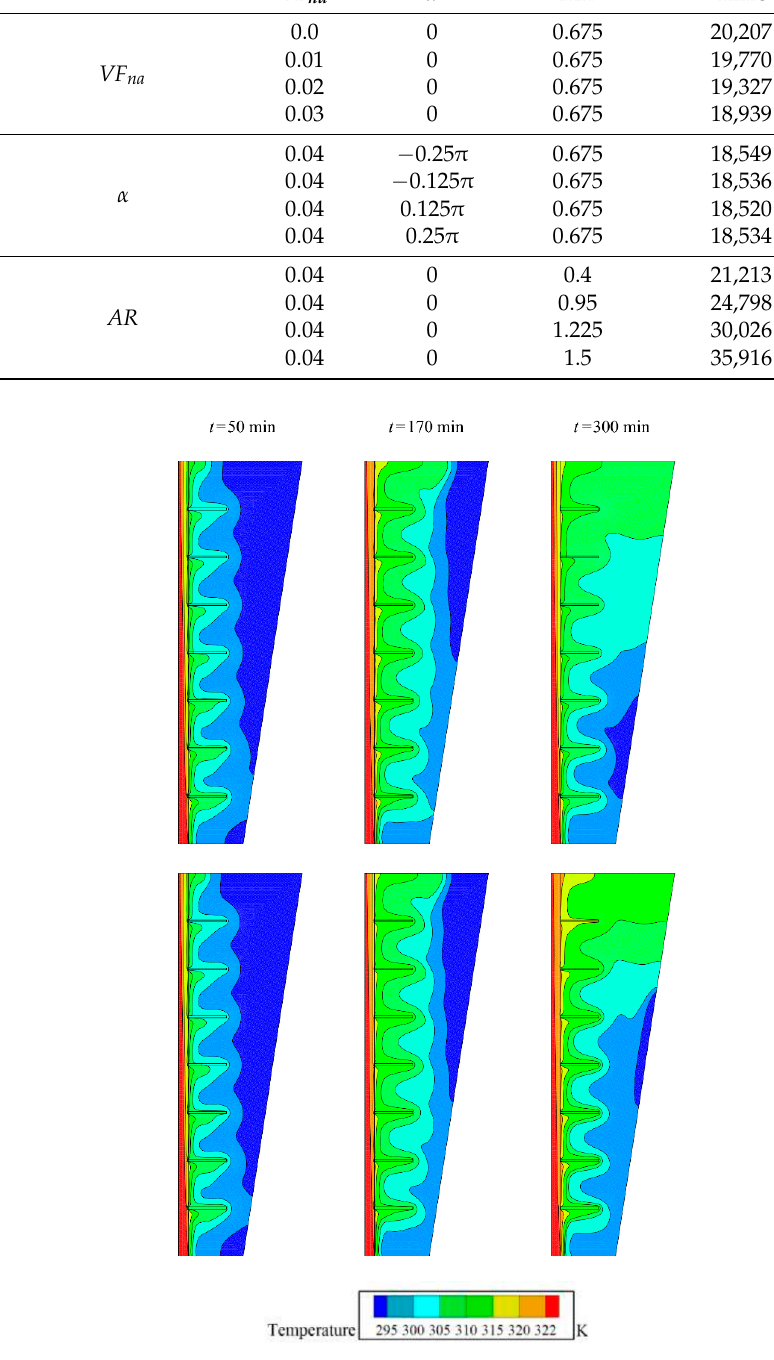
Figure 5. Effect of volume fraction of nanoparticles ( VF na ) on the contours of isotherm: the optimum case with VF na = 0.04 at top, and no nanoparticles ( VF na = 0) at the bottom.